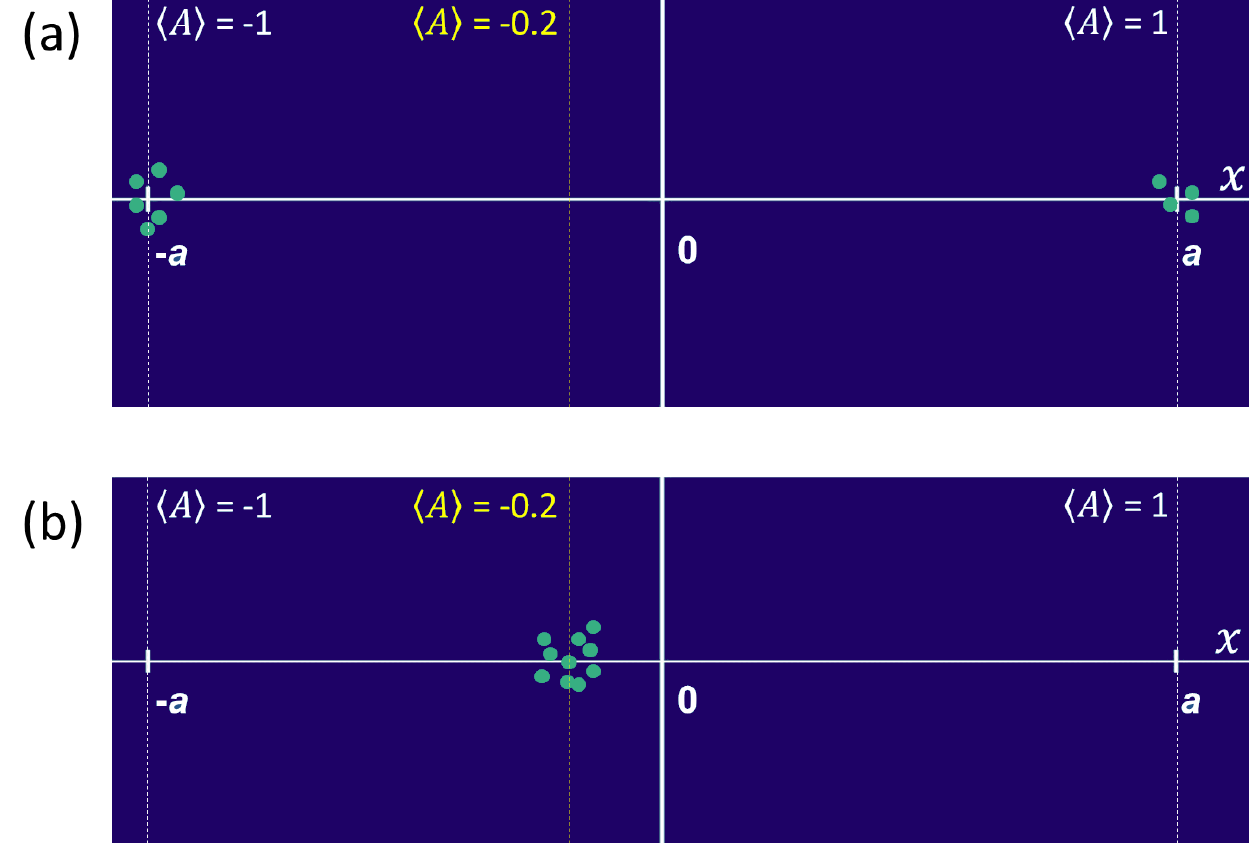
Figure 1. Theoretical framework (ideal pictorial representation). ( a ) Projective measurement: the two polarization com- ponents are completely separated, with the single photons impinging on two regions of the detector corresponding to the polarization operator eigenvalues A = ± 1. The expectation value (cid:104) A (cid:105) is evaluated as the weighted average of the events, following Equation (8). ( b ) Protective measurements: all the photons fall in the same region, centered in a position proportional to the polarization expectation value (see Equation